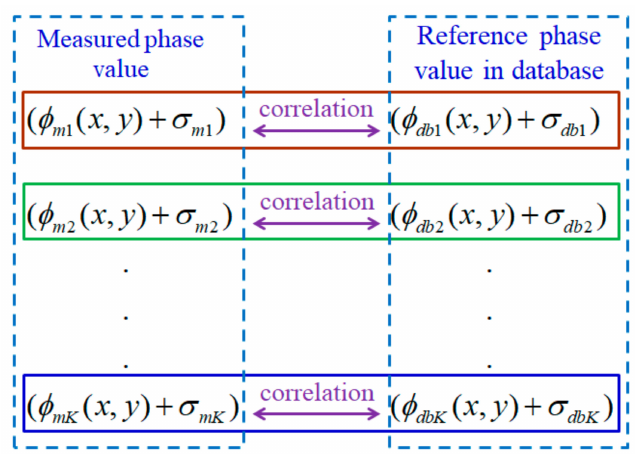
Figure 3. Concept illustration of the correlation between multifrequency measured phases and the reference phases of K -frequencies stored in the